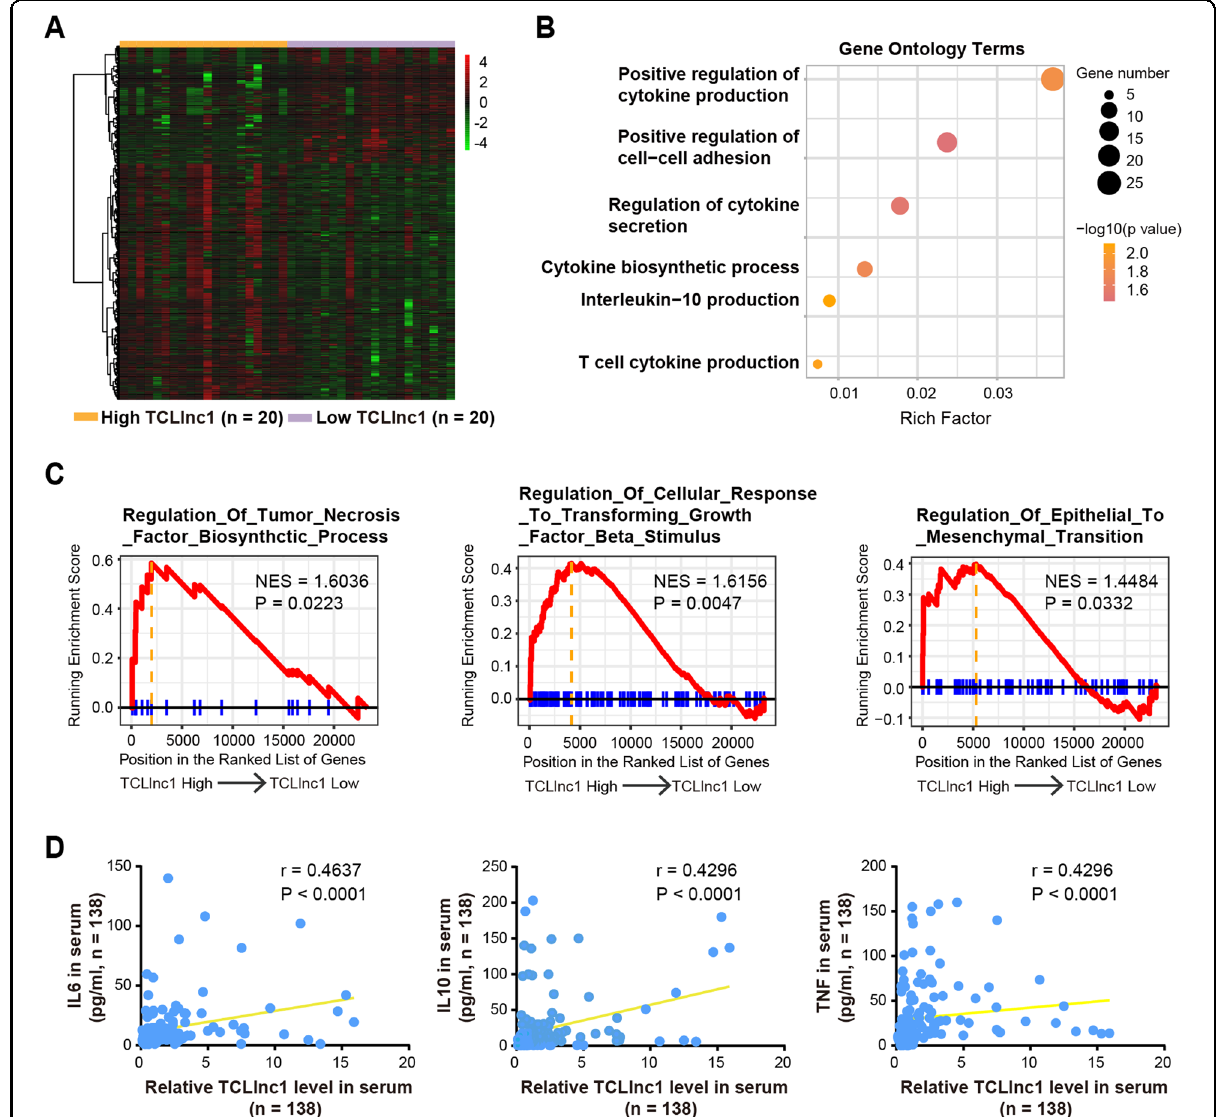
Fig. 5 TCLlnc1 activated TGF- β signaling and increased cytokine production. A RNA-seq data of tumors of PTCL patients ( n = 40) according to TCLlnc1 expression. B Gene ontology terms of differentially expressed genes according to TCLlnc1 expression in tumors. C Gene set enrichment analysis (GSEA) according to TCLlnc1 expression in tumors. D Correlation of TCLlnc1 expression with cytokines levels in serum of PTCL patients ( n =